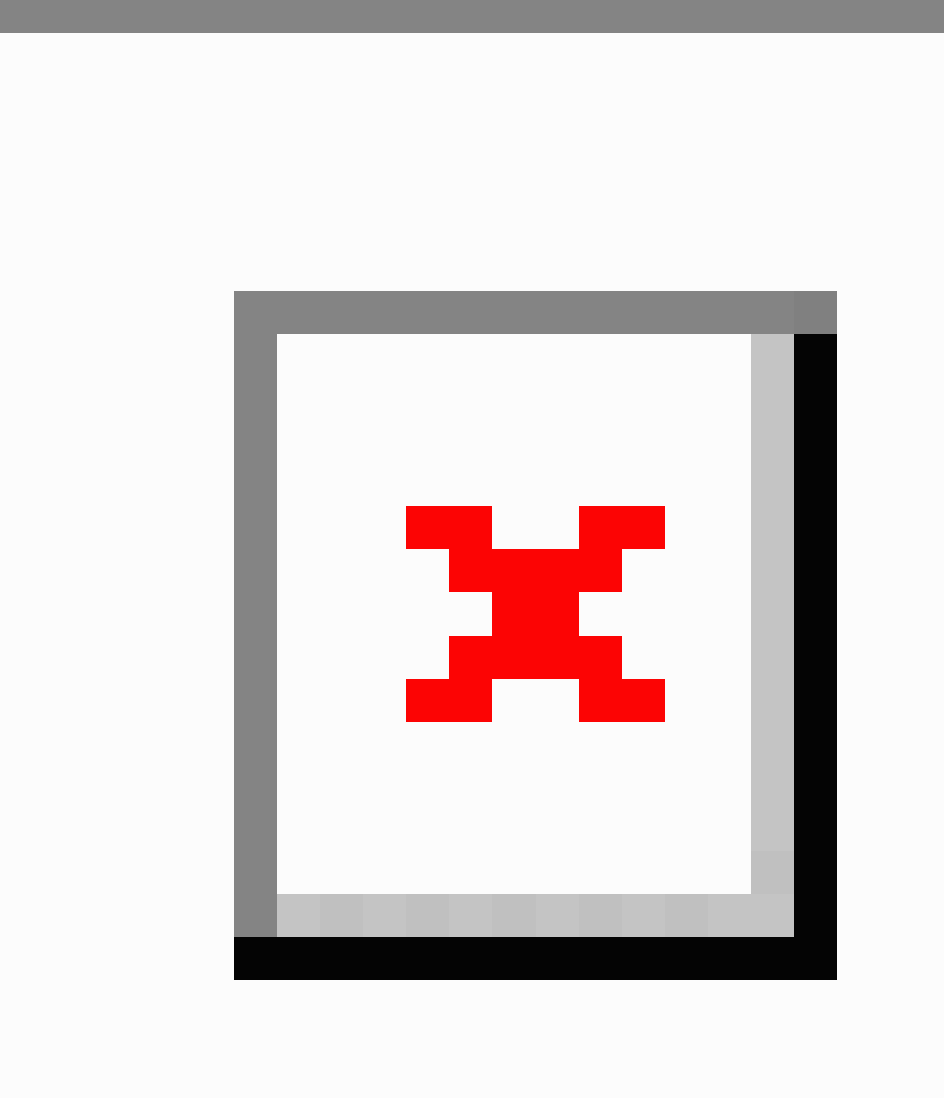
Figure 4. Unadjusted means for prosocial intervening behavior across 3 time points for RealConsent and attention-placebo comparison